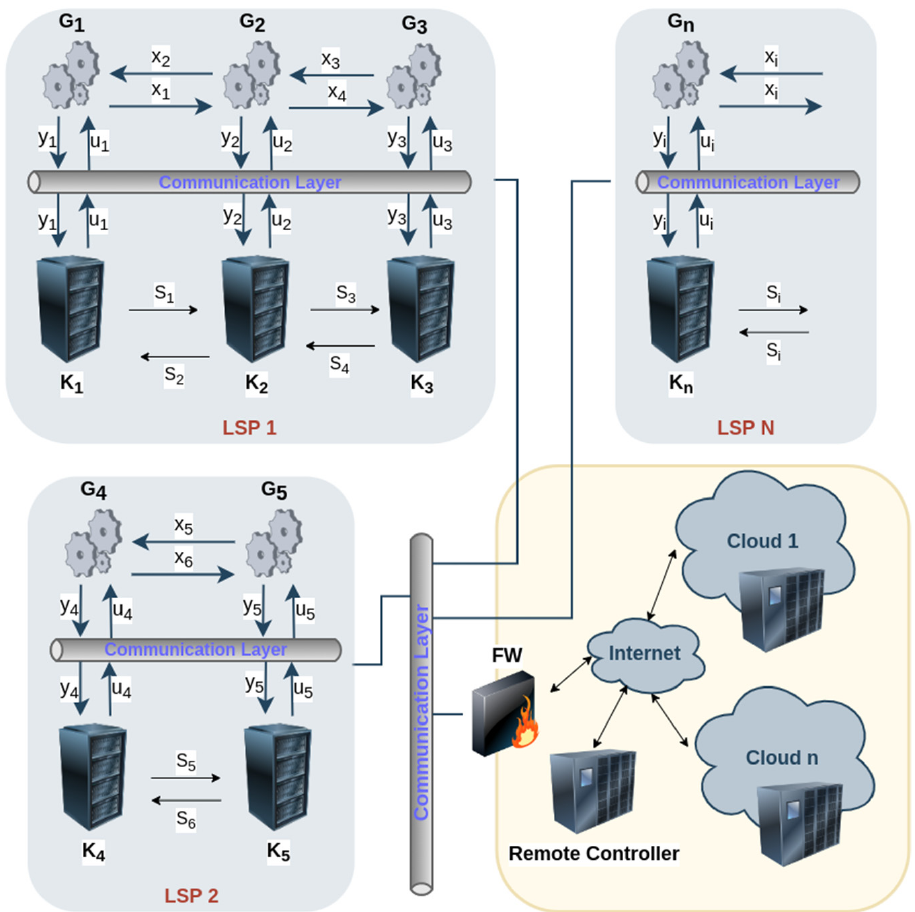
Figure 2. Example of communication flows in a distributed manufacturing system.